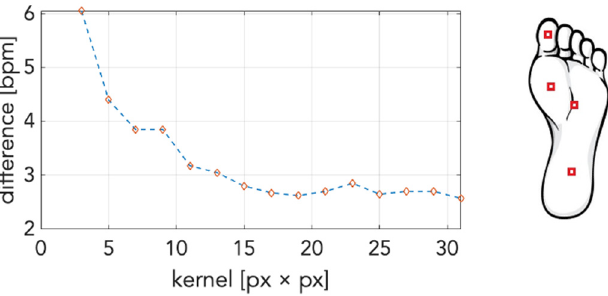
Figure 4. Left—Different averaging masks and their impact on HR accuracy, right—foot with marked marked locations for signal extraction. locations for signal